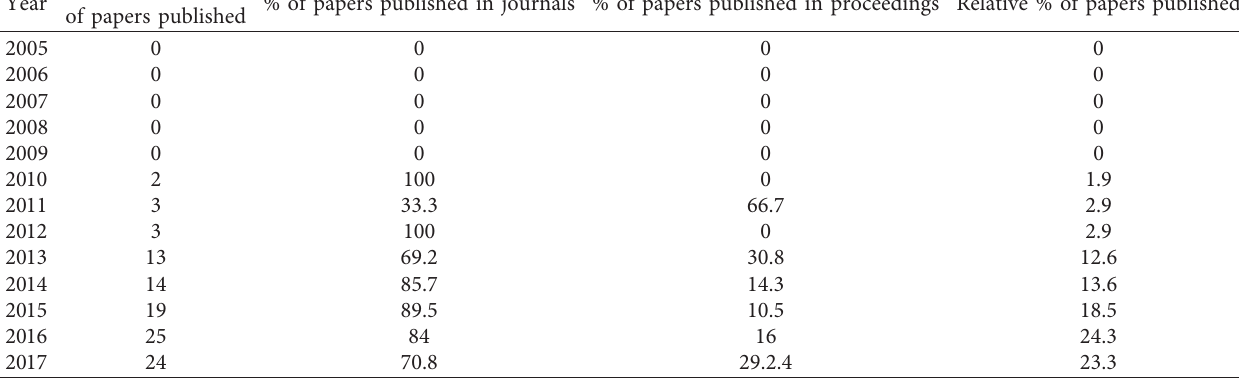
Table 3: Amount of papers published per